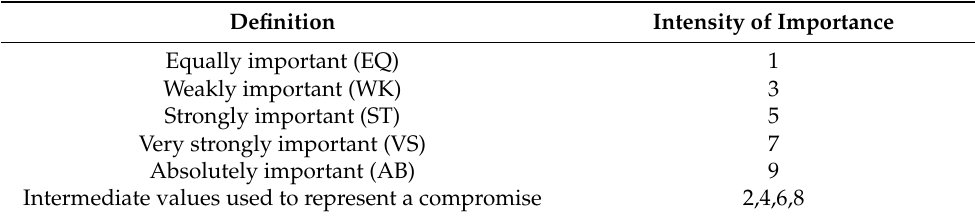
Table 2. Linguistic variables for priority weights of influential criteria.